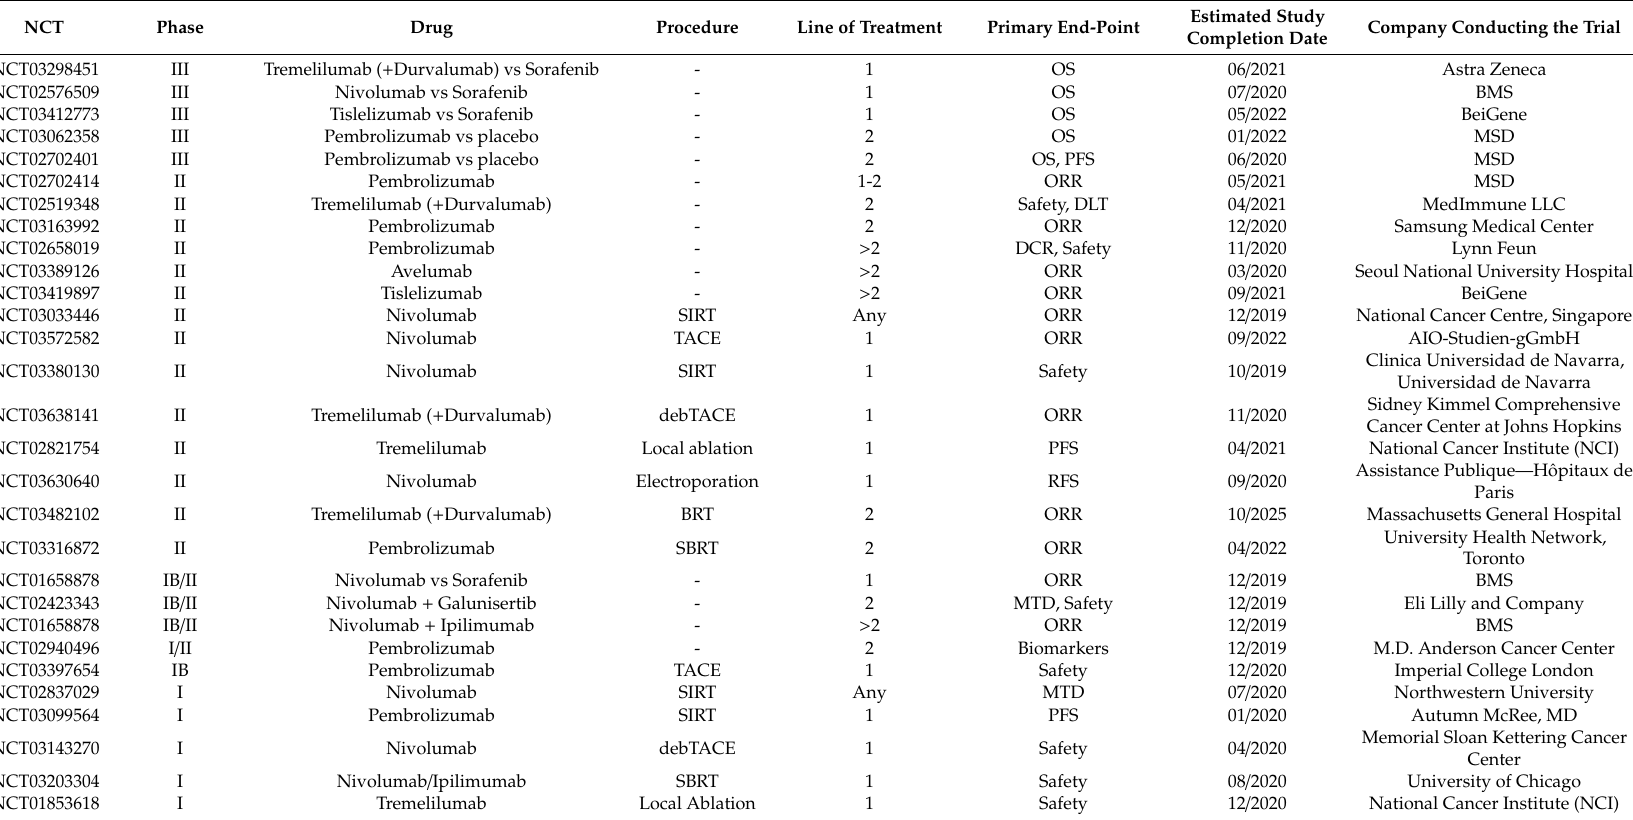
Table 1. Ongoing clinical trials exploring immune checkpoint inhibitors: alone, in combination with other drugs or with local